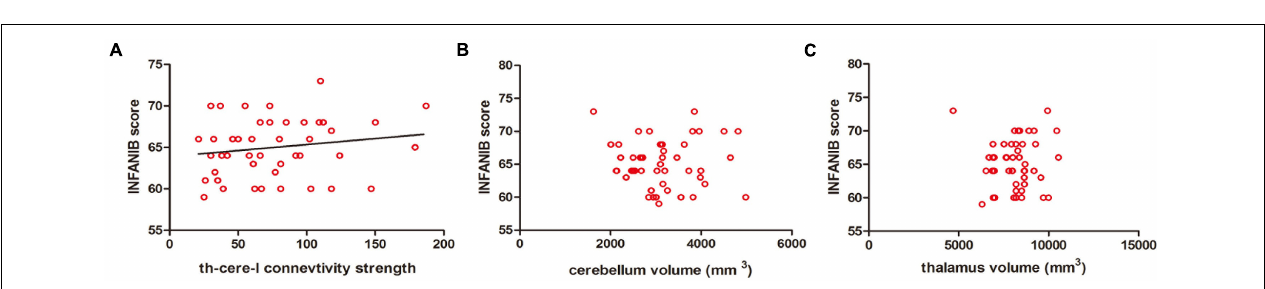
FIGURE 5 | Correlations between the motor scores of INFANIB and brain structural connectivity at 3 months old. (A) The structural connectivity between the cerebellum and ipsilateral thalamus was positively correlated with the scores of INFANIB at 3 months old. r = 0.347, p < 0.05. (B,C) The volume of the cerebellum and thalamus were not linearly related with the scores of INFANIB at this age. r = 0.056, p = 0.930/ r = 0.047, p = 0.951. cere, cerebellum; th, thalamus; I,